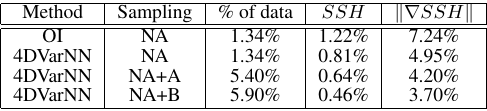
Table 3. Impact of the sampling design on reconstruction performance for SSH fields: for different sampling designs, we evaluate the reconstruction performance in terms of mean square error of the SSH field and of the norm of the gradient of the SSH field for the test dataset normalised by the variance of the groundtruthed reference. As baseline, we consider an Optimal interpolation using nadir along-track data. We then compare three configurations of the proposed end-to-end learning using nadir altimeter data solely, combined with a trained sparse sampling design constrained to horizontal and vertical lines (A) and combined with a trained sparse sampling design with no additional constraint